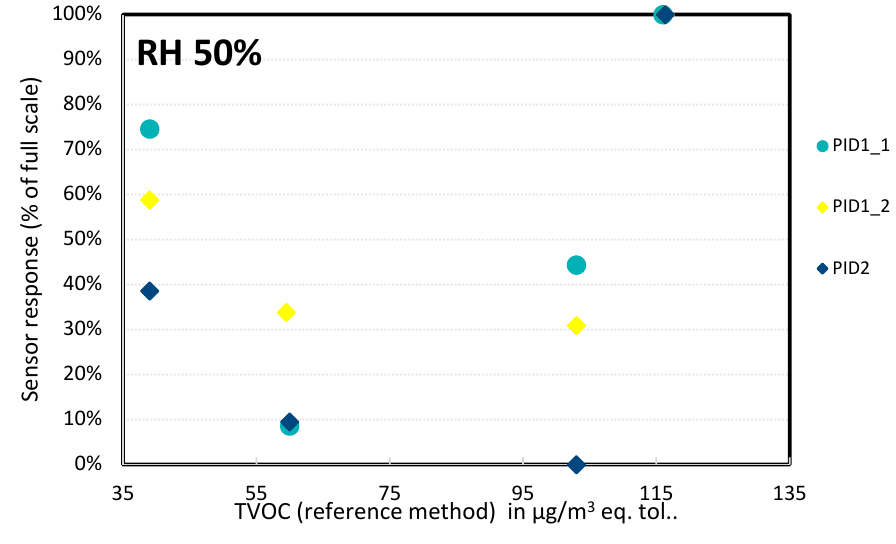
TVOC (reference method) in µg/m 3 eq. tol.. Figure 16. Linearity of PID sensors. Figure 16. Linearity of PID